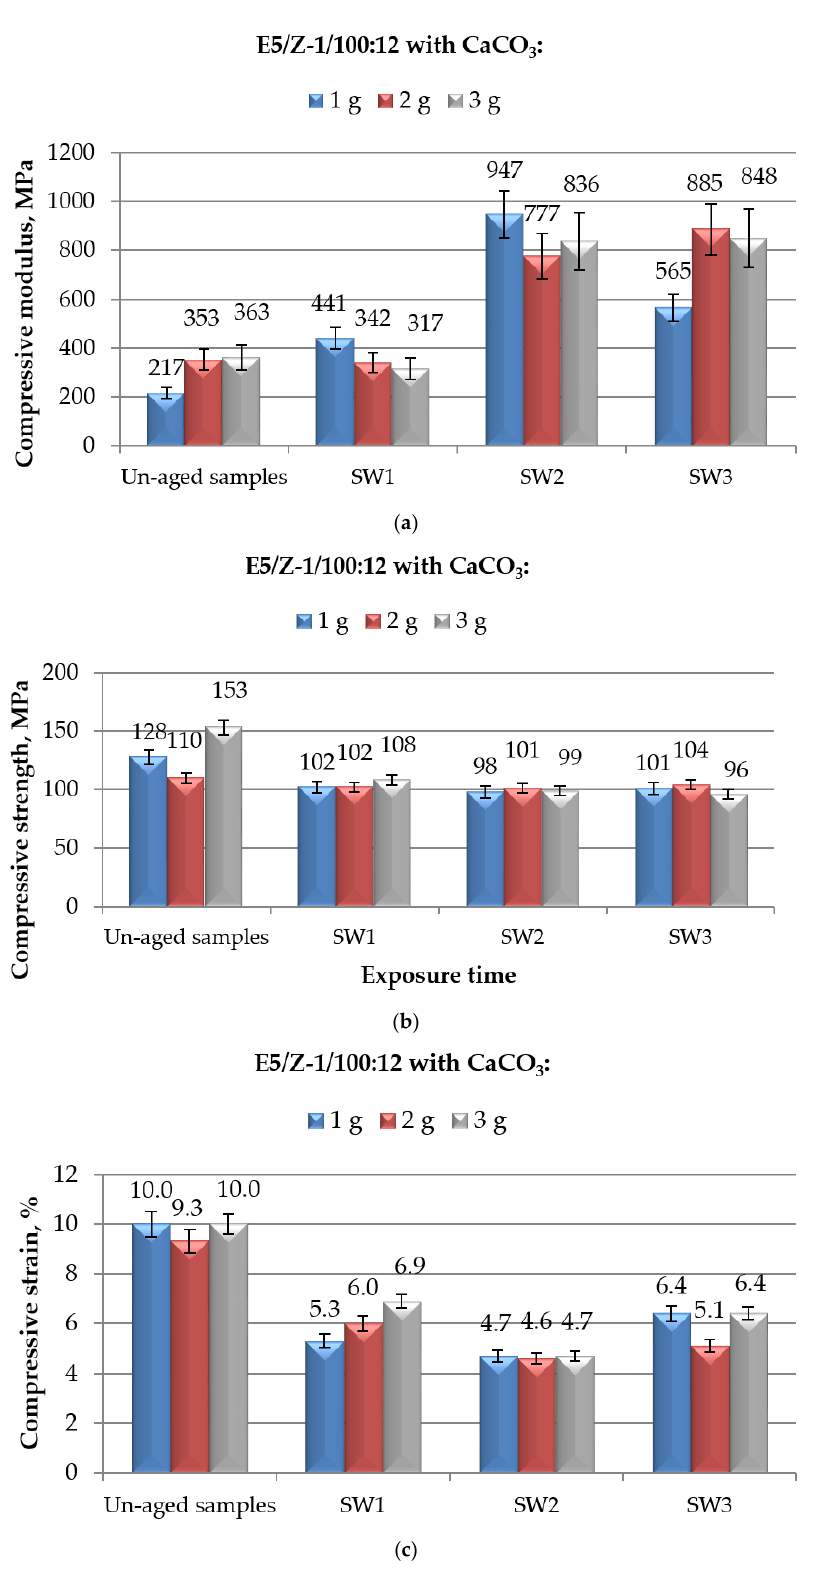
Figure 9. Results of mechanical (in compression mode) tests performed on E5 / Z-1 / 100:12 epoxy compounds filled with di ff erent amounts of CaCO 3 and aged for di ff erent time spans (from 1 to 10 months) in spring water: ( a ) Compressive modulus; ( b ) compressive maximum strength; and ( c ) compressive strain at